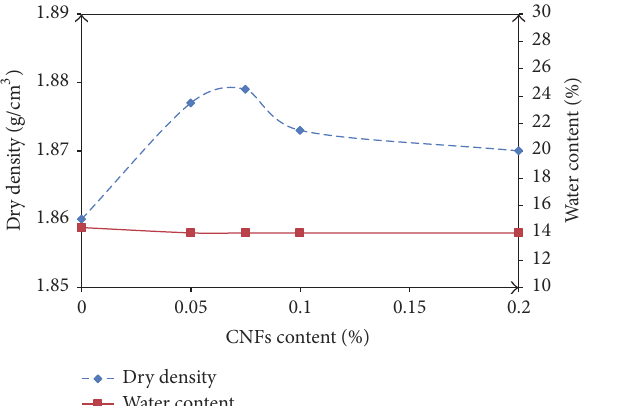
Figure 15: Effect of MWCNTs and CNFs on hydraulic